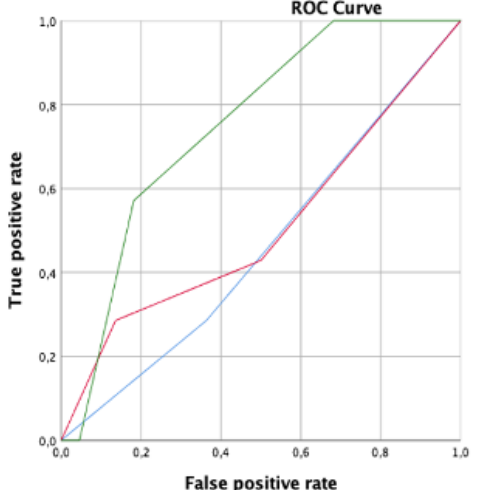
Figure 6. Agreement between laparotomic and radiologic peritoneal cancer index (PCI) in women undergoing interval debulking surgery.